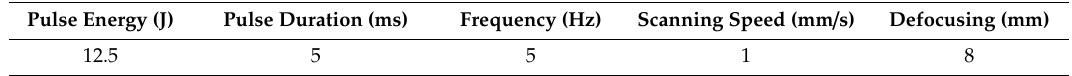
Table 2. Laser surface melting